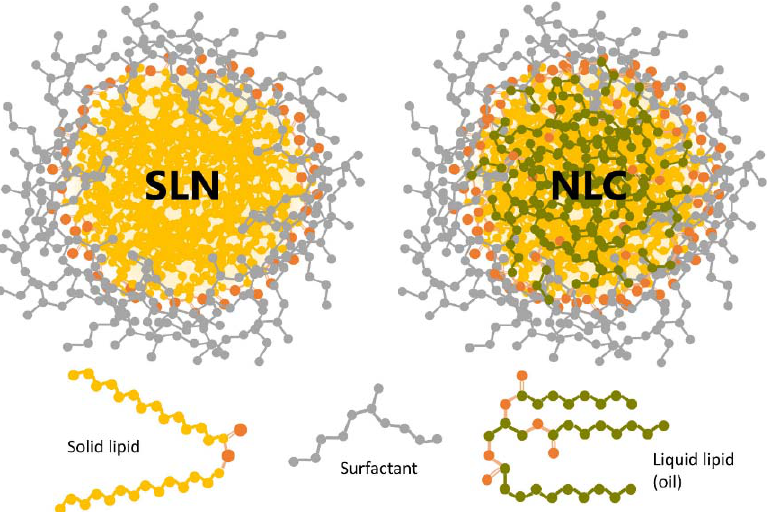
Figure 7. General structures of SLNs and NLCs [72]. Reprinted with permission from ref.